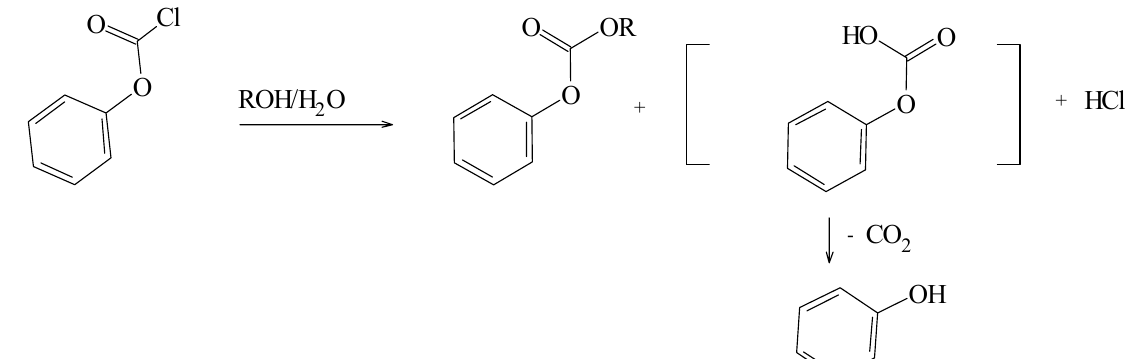
Scheme 1. Alcoholysis plus hydrolysis of phenyl chloroformate ( 4